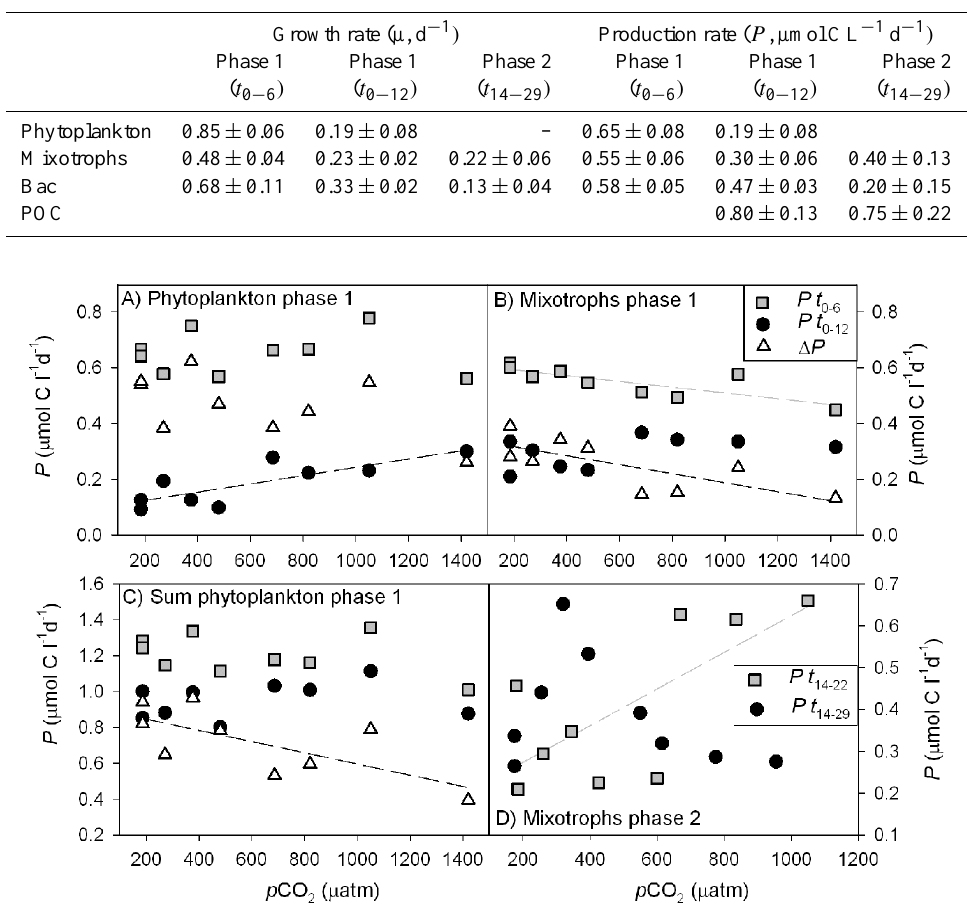
Fig. 3. Production rates vs. average p CO 2 levels of each phase based on data (Eq. 3) of (A) phytoplankton; (B) mixotrophs; and (C) sum phytoplankton and mixotrophs production rates (µmolCL − 1 d − 1 ) in phase 1 for the build-up ( t 0 − 6 ) , the build-up and decline ( t 0 − 12 ) , and the production loss during decline (difference) denoted with (1) ; (D) mixotroph production rates (µmolCL − 1 d − 1 ) after nutrient addition for initial phase 2 ( t 14 − 22 ) and total phase 2 ( t 14 − 29 )